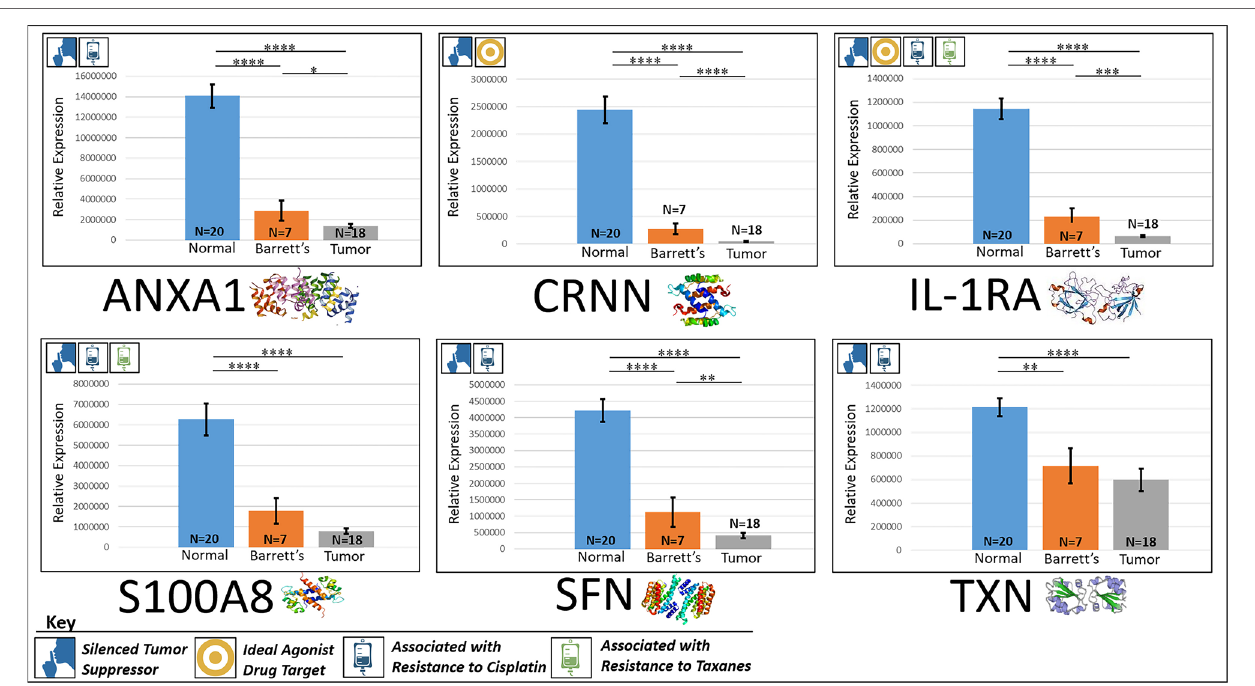
FIGURE 3 | Downregulated tumor suppressors. These six markers are associated with inducing programmed cell death in various cancers and were found to be downregulated in our cohort’s esophageal adenocarcinoma tumor tissue compared to normal squamous esophageal epithelium, possibly contributing to enhanced